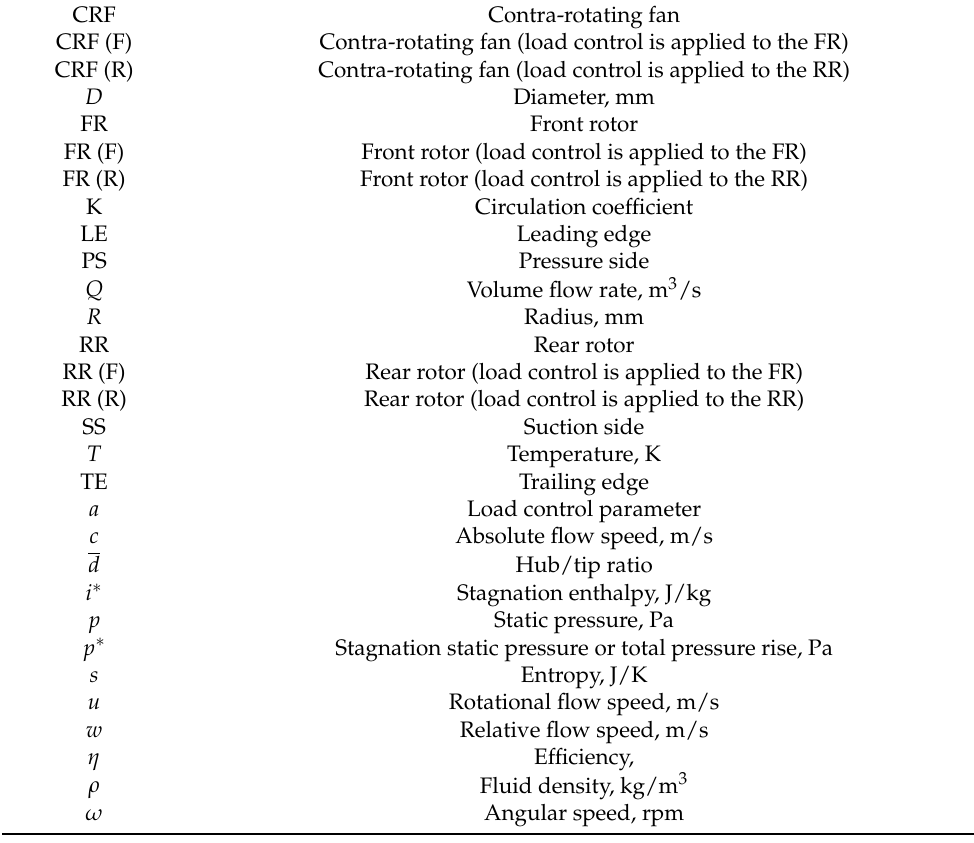
Table A1. Nomenclature and related units for abbreviations.